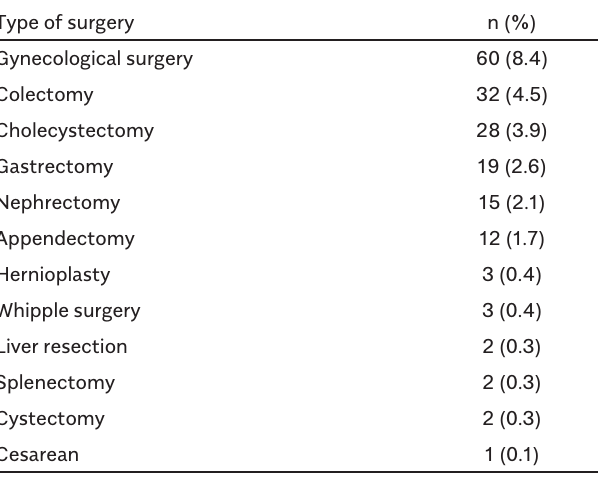
Table 3. Abdominal Surgeries in Patients with Mesenteric Panniculitis Type of surgery n (%) Gynecological